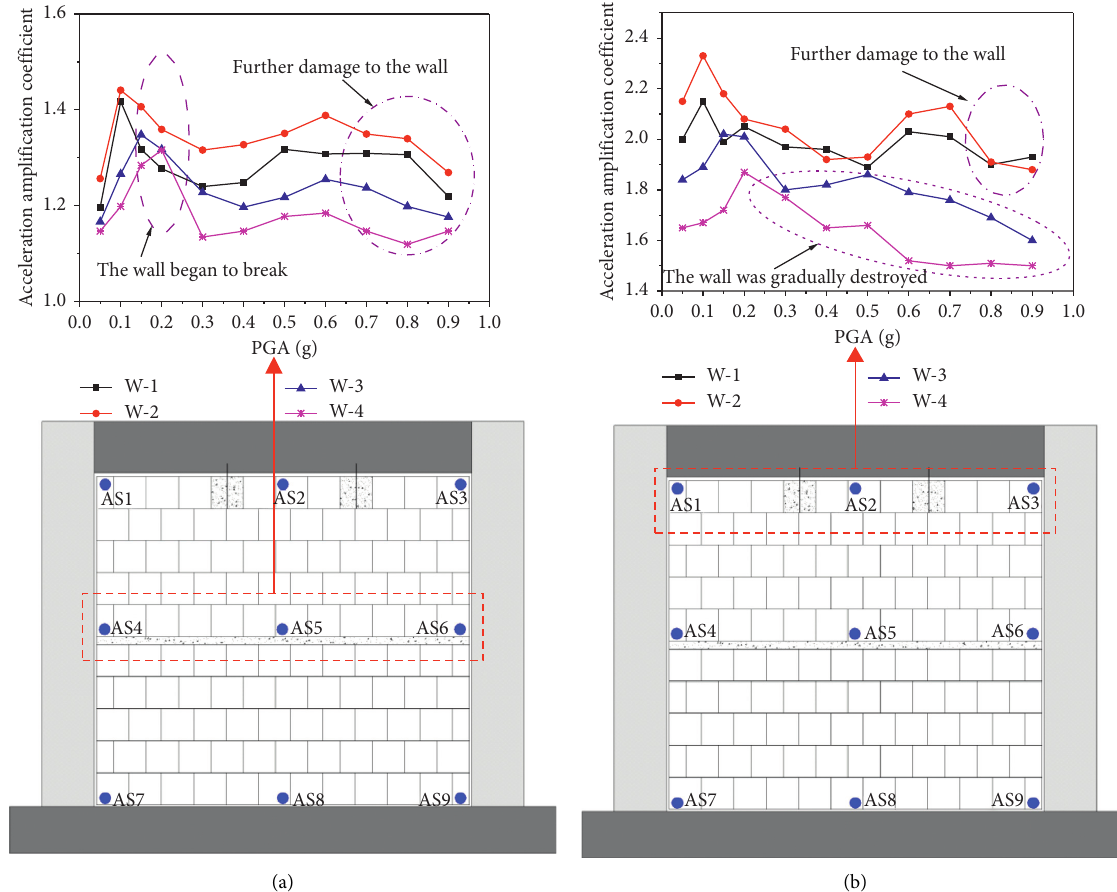
Figure 10: Acceleration amplification coefficient of the wall. (a) In the middle of the wall. (b) At the top of the wall.